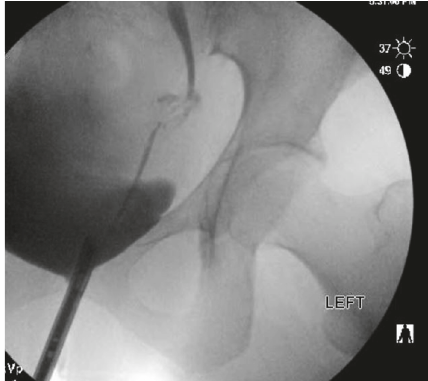
Figure 5: Mild extravasationnoted on the left ureterwith continued contrast